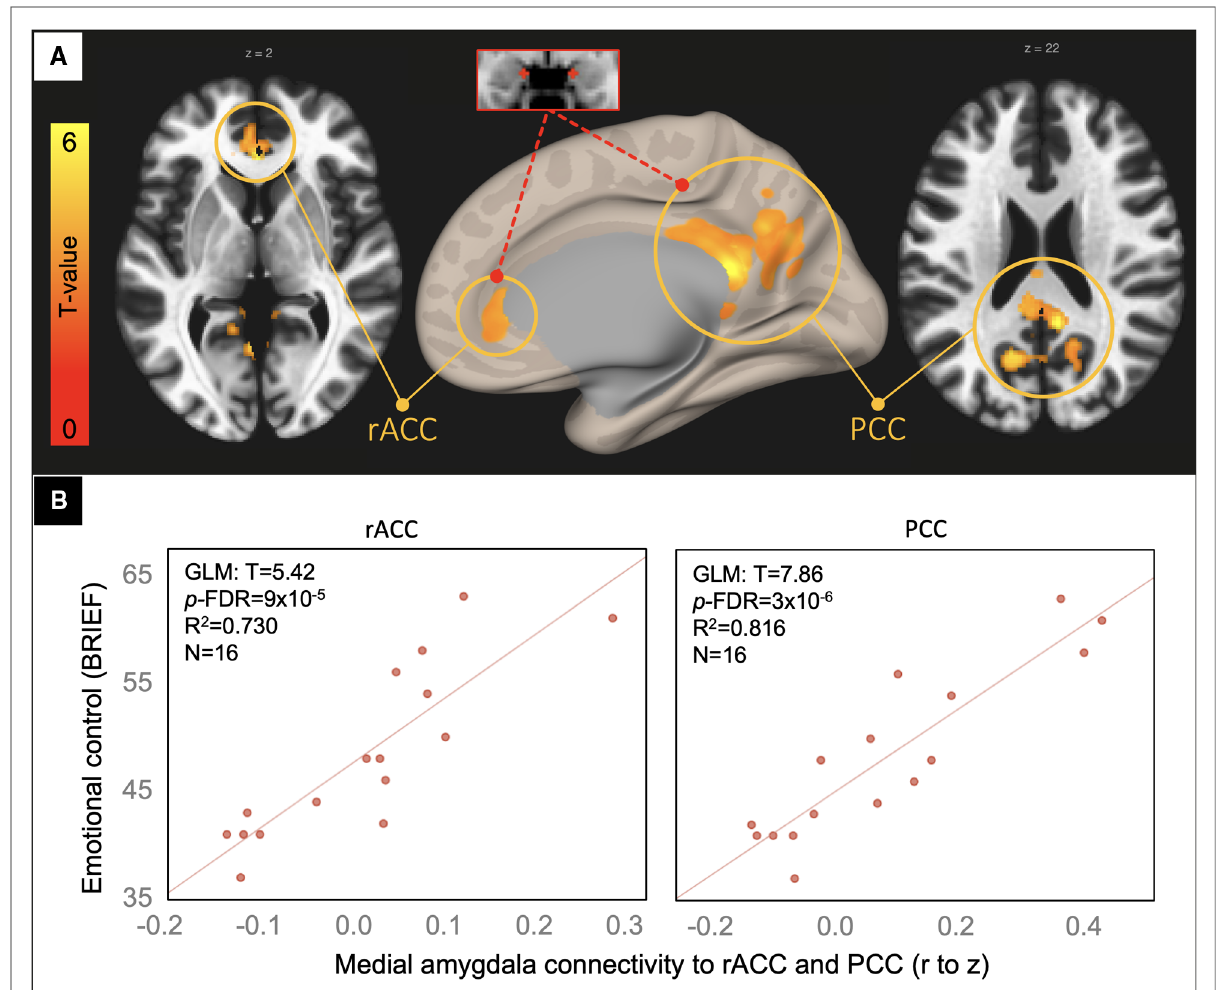
FIGURE 3 Voxelwise correlation between BRIEF emotional control ratings and medial amygdala connectivity. Resultant clusters of voxels in the rostral anterior cingulate cortex (rACC) and posterior cingulate cortices (PCC) for the regression of BRIEF Emotional Control ratings on medial amygdala rFC ( A , p -uncorrected<0.01 with cluster-size p -FDR corrected<0.05). Scatter plots (B) showing the correlation between rFC of the medial amygdala to peak voxels in the rACC and PCC clusters (x-axis) and the BRIEF scale (y-axis) with overlaid statistics for the GLM on the fi rst row of plots derived from the voxelwise